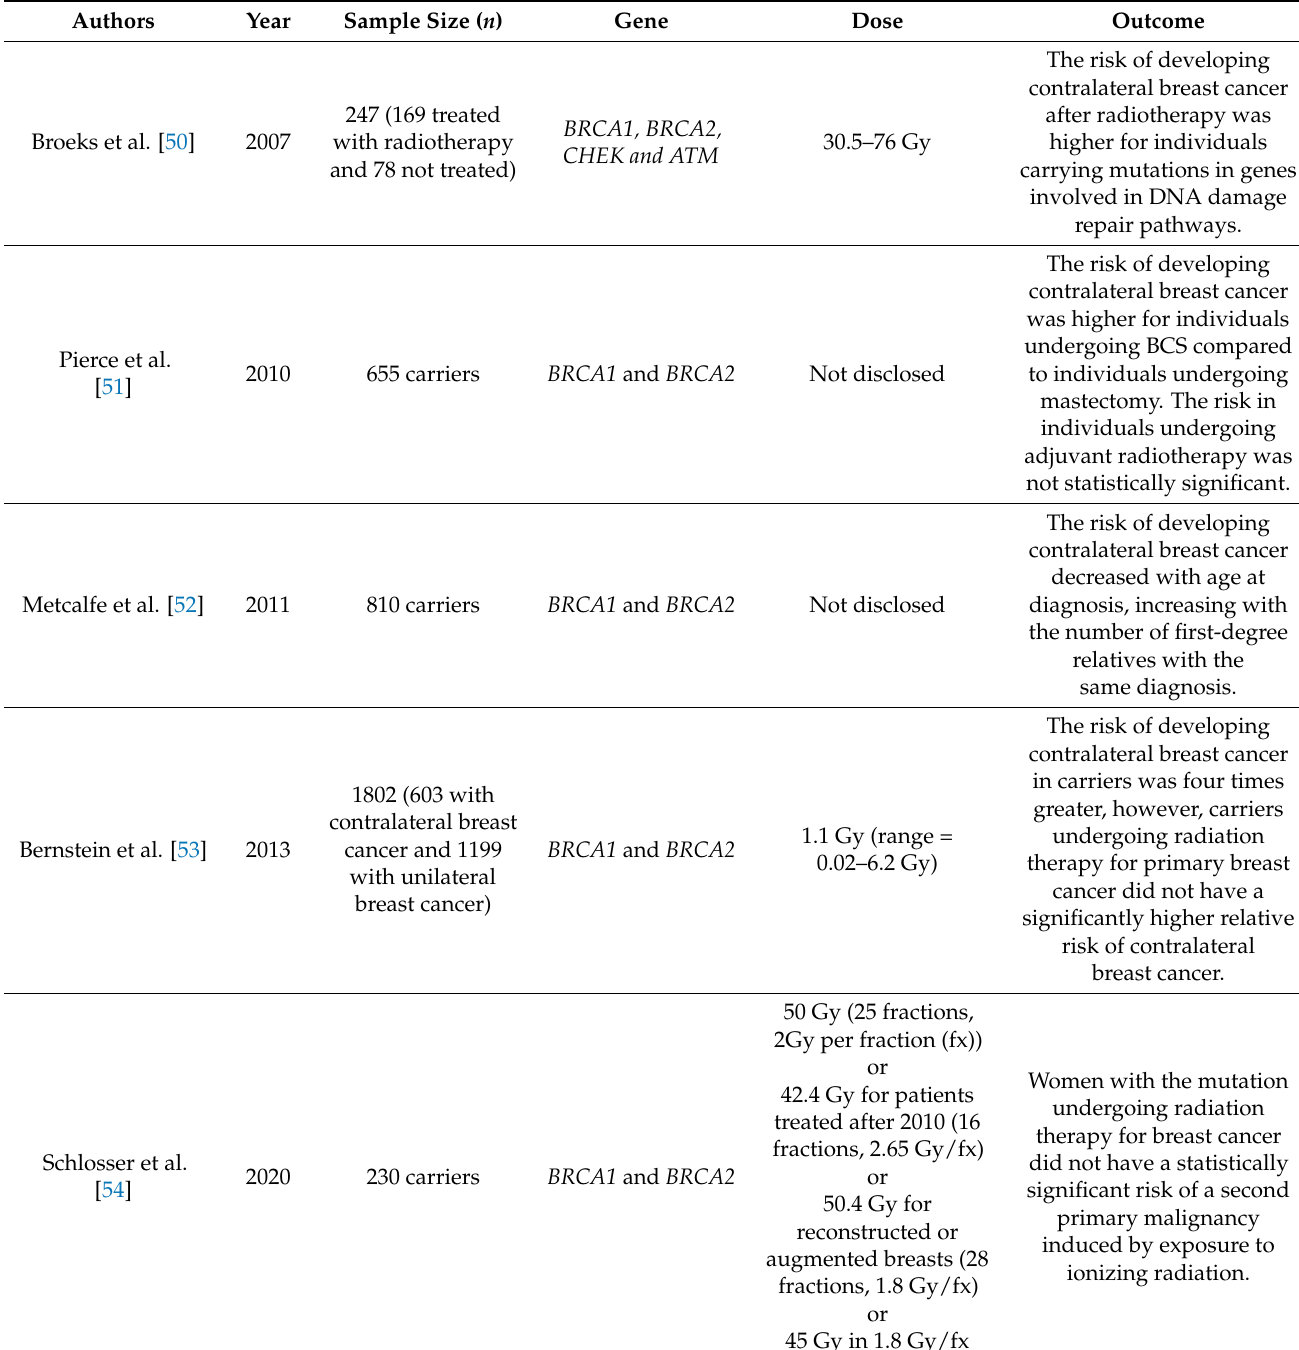
Table 2. Summary of studies carried out that evaluated the risks associated with exposure to ionizing radiation, associated with radiotherapy, in carriers of mutations in the BRCA1 and BRCA2